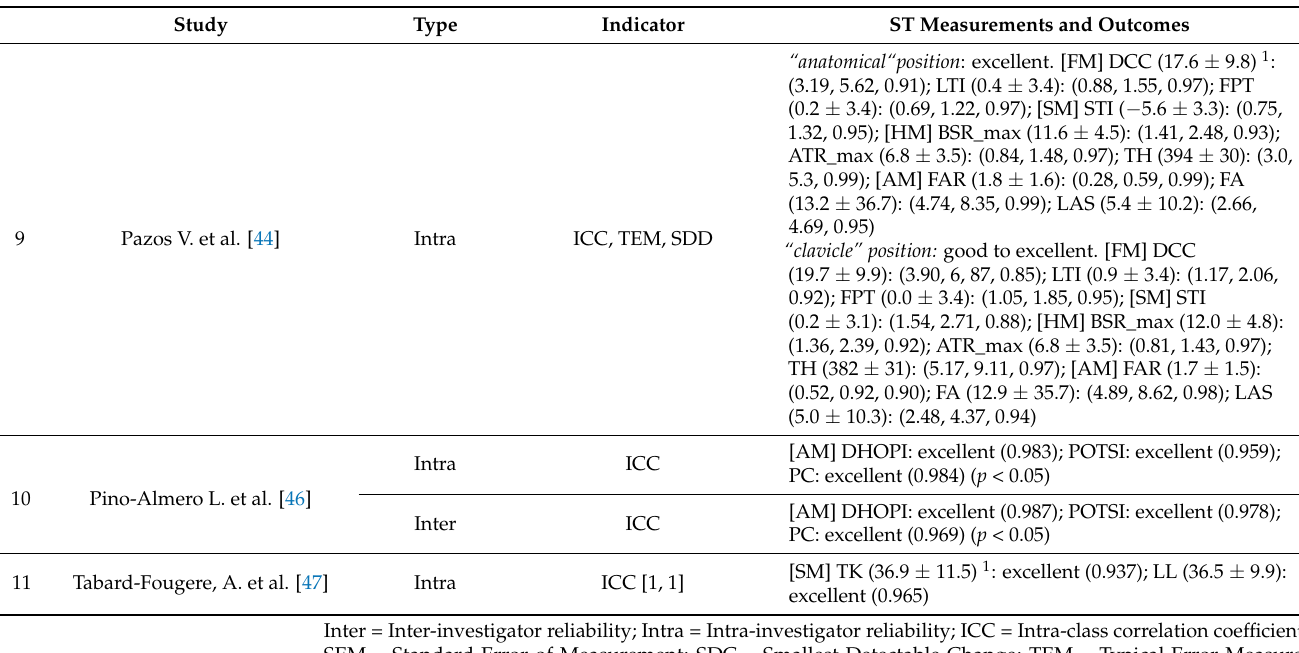
Inter = Inter-investigator reliability; Intra = Intra-investigator reliability; ICC = Intra-class correlation coefficient; SEM = Standard Error of Measurement; SDC = Smallest Detectable Change; TEM = Typical-Error Measure- ment; SCC = Spearman correlation coefficient; CV = Coefficient of variation; P = The p -value of a paired t -test; FM = Frontal measurements; SM = Sagittal measurements; HM = Horizontal measurements; AM = Asymmetry measurements; (frontal, sagittal, and horizontal measurements are those where the anatomical landmarks used in the measurement are located in the corresponding planes. Asymmetry measurements reflect body asymmetry and usually involve more than one plane or more than one body region). SA = Scoliosis angle; PO = Pelvis obliquity; TL = Trunk length; TK = Thoracic kyphosis angle; LL = Lumbar lordosis angle; VO_rms = RMS surface rotation